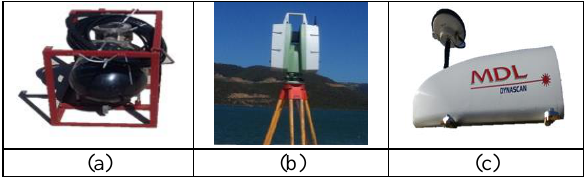
Figure 2 . Equipment of experimentation: (a) Reason Seabat 7101 multi-beam echo-sounder, (b) Leica C10 TLS, (c) MDL Dynascan laser scanner